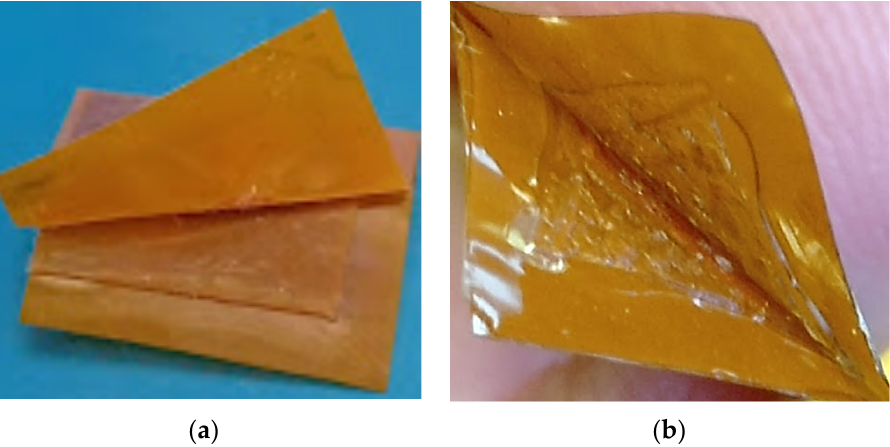
Figure 2. Peel-off test ( a ) Adhesive failure between PDMS and Polyimide ( b ) Cohesive failure of PDMS proofing irreversible bonding between polyimide and PDMS.